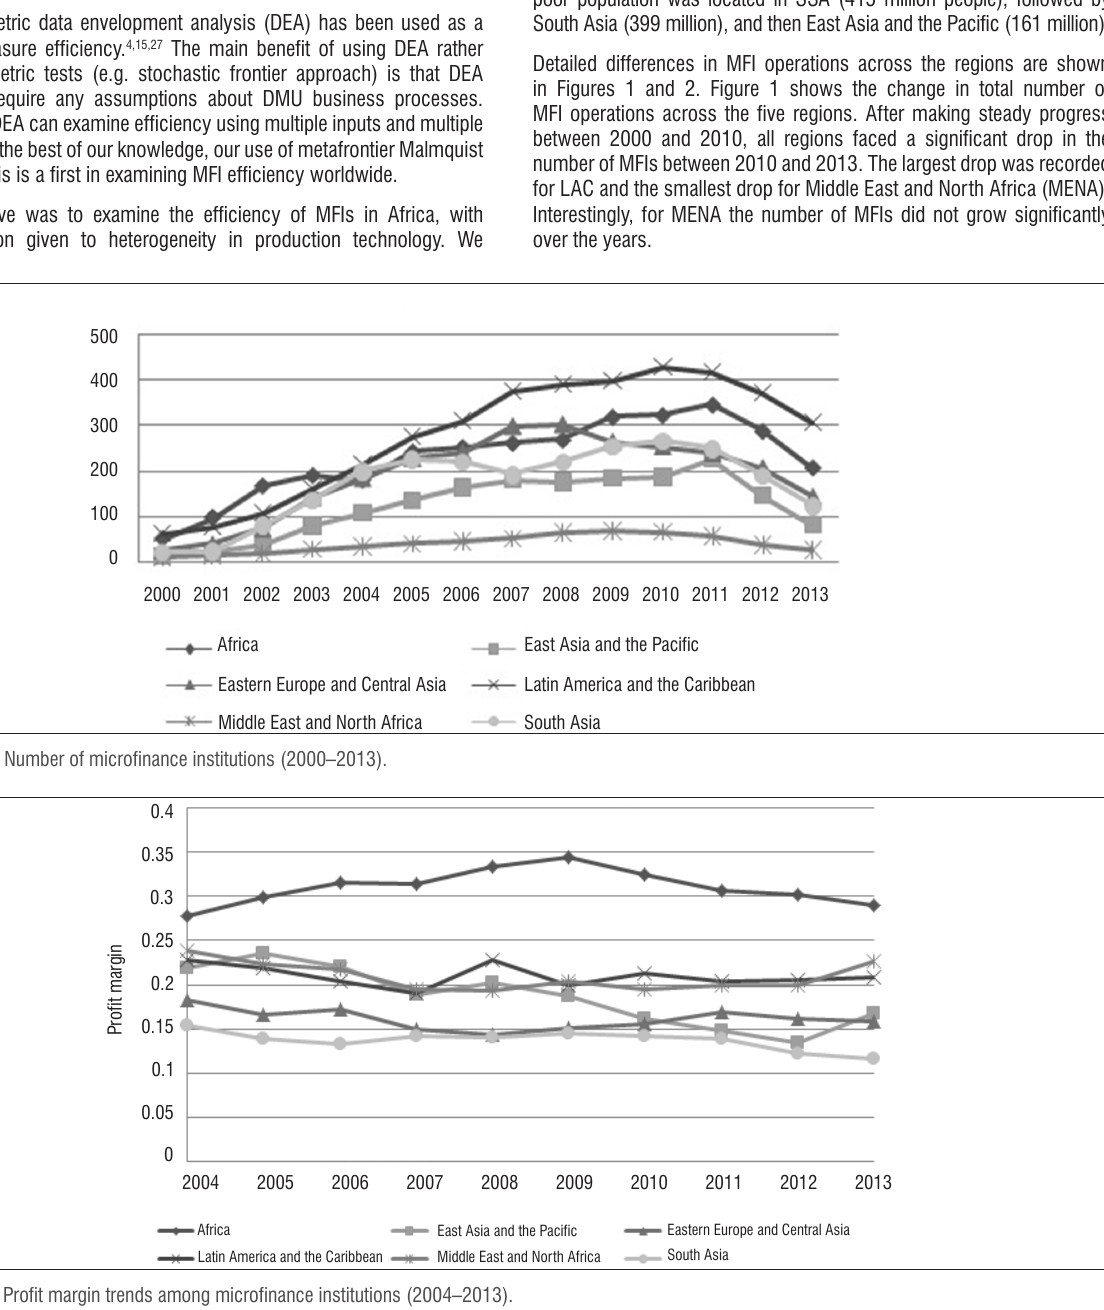
Figure 2: Profit margin trends among microfinance institutions